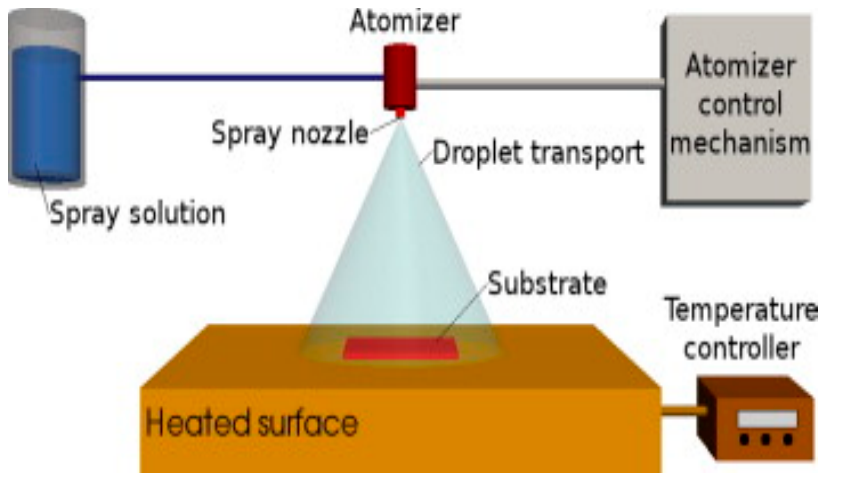
Figure 12. Schematic diagram of spray pyrolysis process [72].